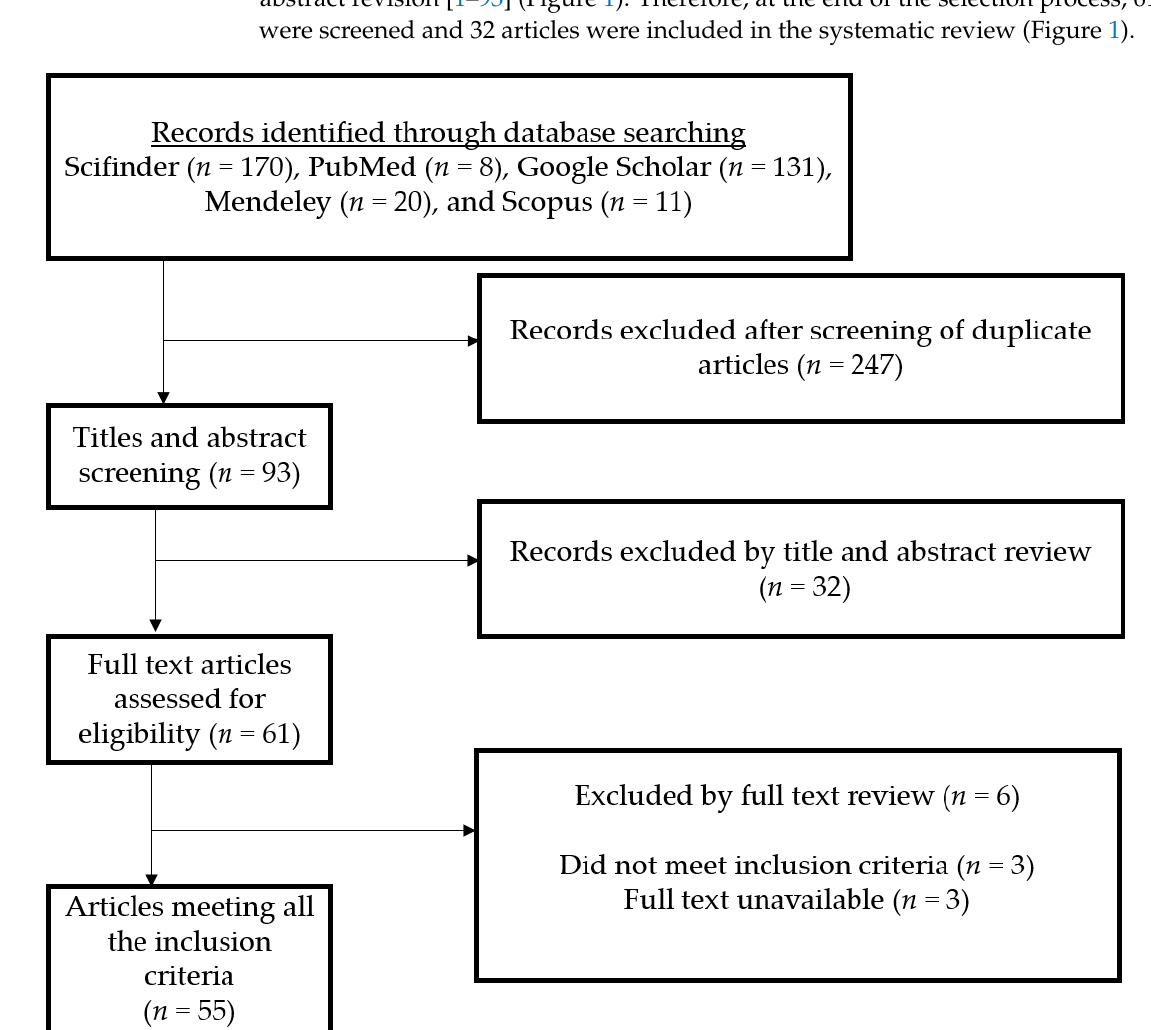
Figure 1. Systematic review and meta-analysis preferred reporting items.